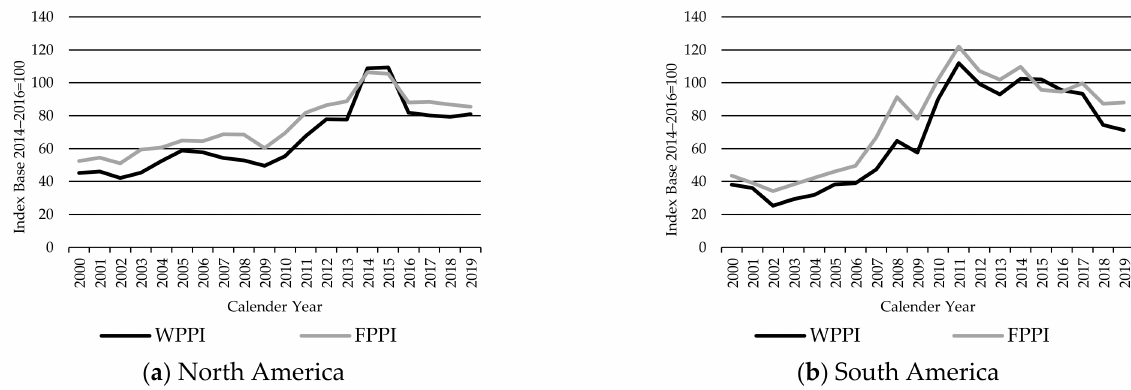
Figure 8. The Finished Cattle Producer Price Index FPPI and Weaner Cattle Producer Price Index WPPI in North ( a ) and South America ( b ), source: own illustration.